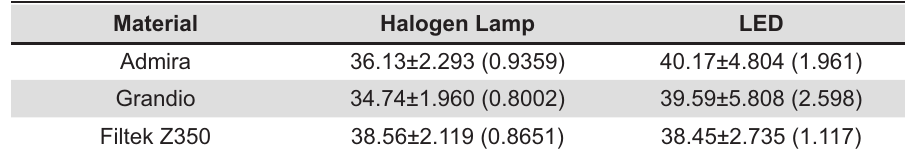
(cid:17)!"#"$(cid:11)’(cid:11)*(cid:25)(cid:8)(cid:11)(cid:18)(cid:8)(cid:7)(cid:8)(cid:9)(cid:18)(cid:8)(cid:9)(cid:24)(cid:7)(cid:6)(cid:6)(cid:22)(cid:11)(cid:18)(cid:9)(cid:30)(cid:26)(cid:9)(cid:31)(cid:24)(cid:7)(cid:26)(cid:8) groups as indicated by the Tukey’s